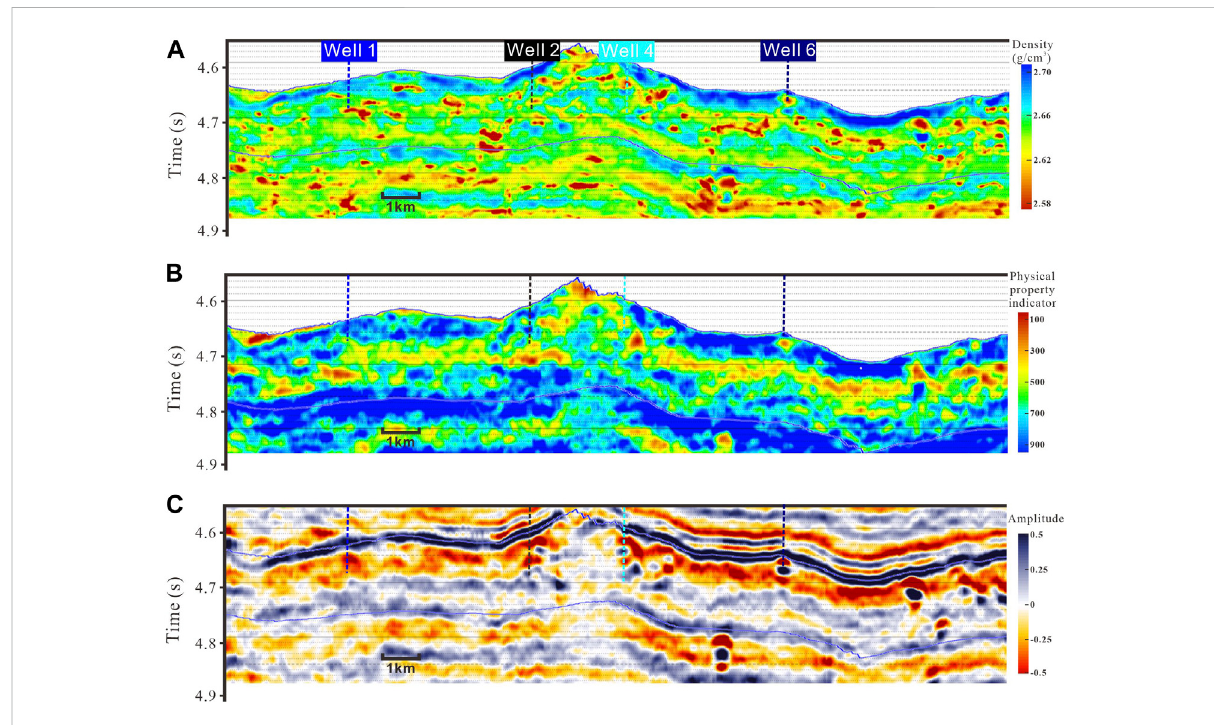
Pro fi les along the main fault zone based on (A) density, (B) the physical property indicator, and (C) stack seismic traces.